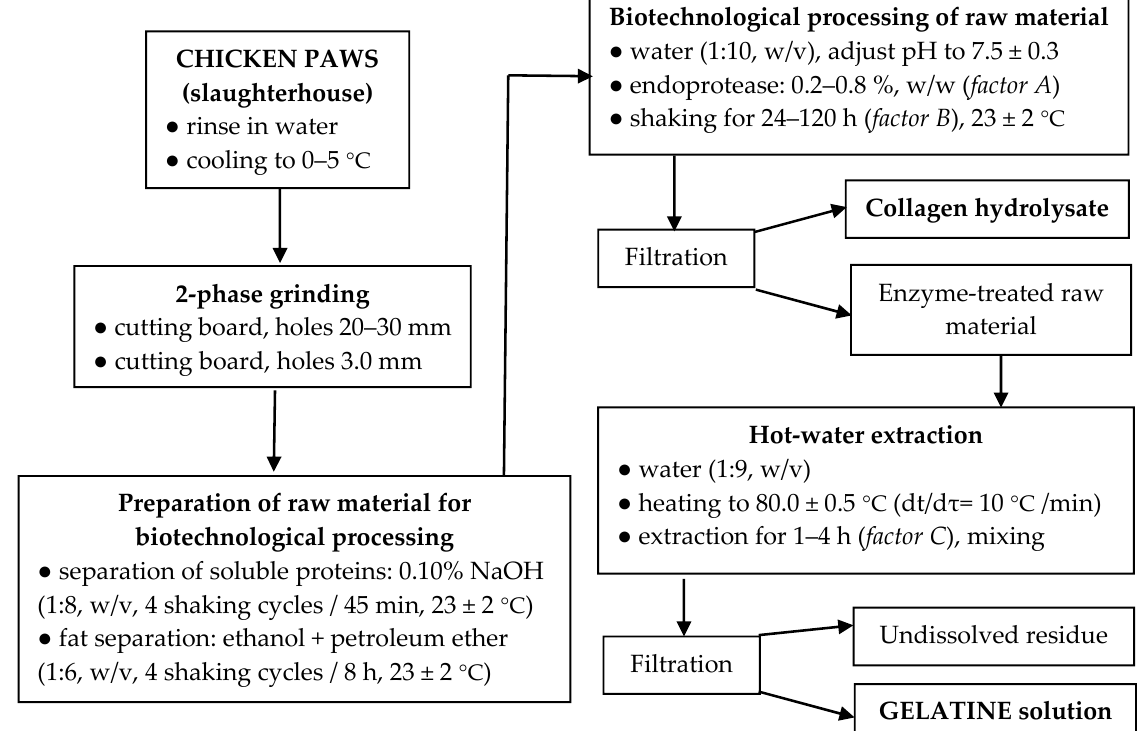
Scheme I. A flow chart of preparation of gelatins from chicken feet. Scheme 1. A flow chart of preparation of gelatins from chicken